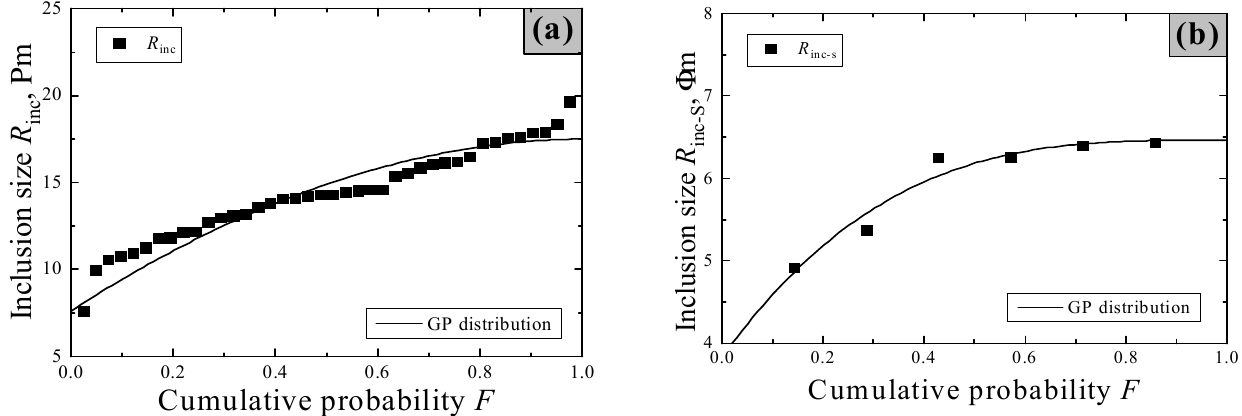
also had the same conclusion. If the inclusion size with a cumulative probability of 99.9%, represented by R inc or inc-s,99.9% , is defined as the maximum inclusion size for carburized Cr-Ni gear steel, then the maximum inclusion size is 17.50 µ m for interior failure and is 6.46 µ m for surface failure.